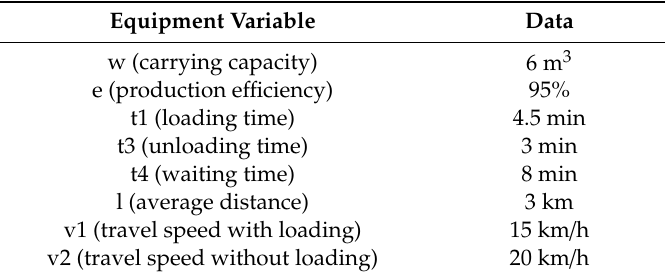
Table 6. Mixer-truck variable data.